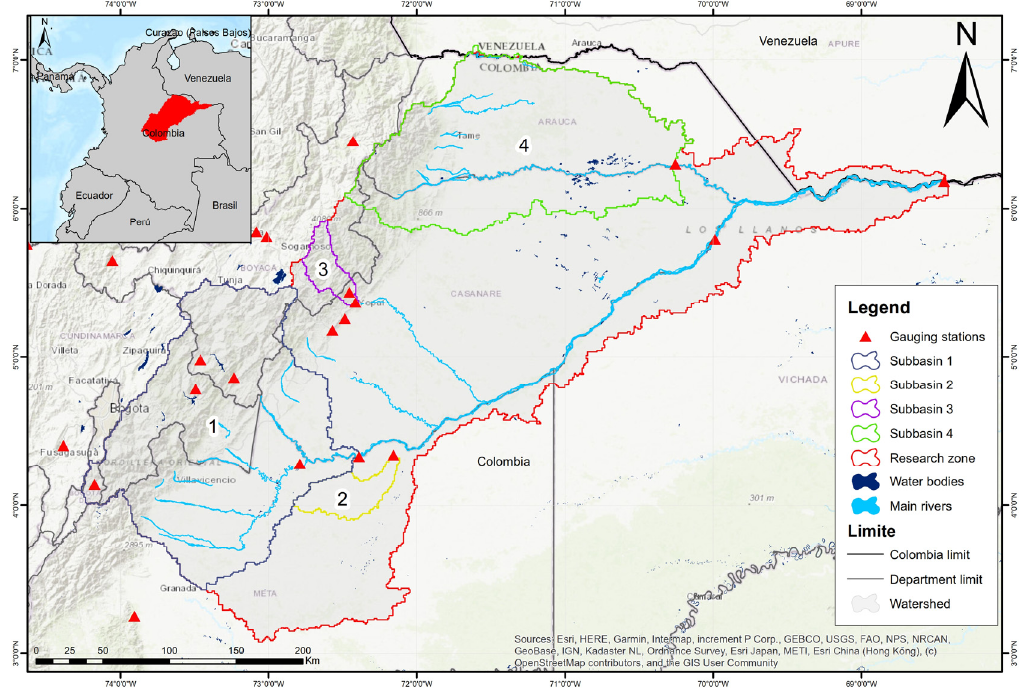
Figure 1. Location of the Meta River basin (Research zone) and its subbasins in Colombia. Subbasin 1: upper Meta River subbasin; Subbasin 2: Yucao River subbasin; Subbasin 3: South Cravo